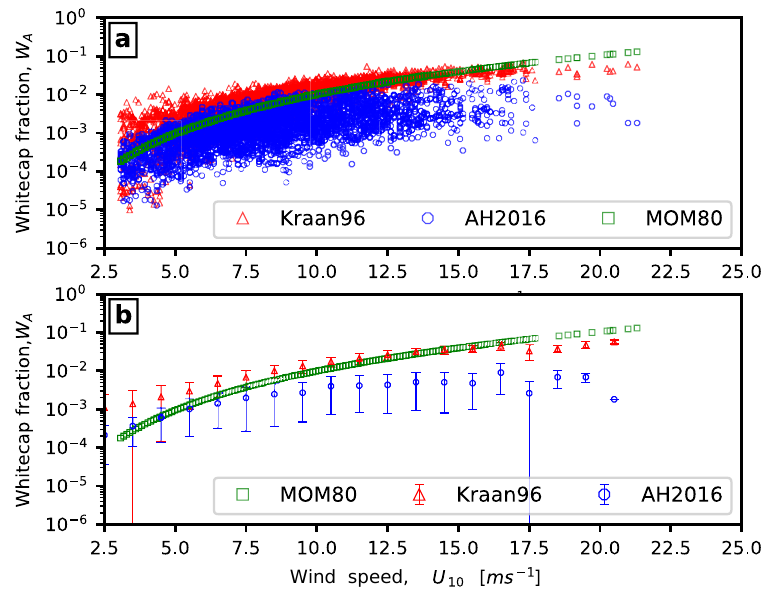
Figure 1. Wind speed dependence of the whitecap fraction (on log scale) obtained from (a) Kraan96 (Kraan et al., 1996), AH2016 (Anguelova and Hwang, 2016), and MOM80 (Monahan and Muircheartaigh, 1980). (b) As in (a) , but data are binned in wind speed bins of 1ms − 1 using data from buoy 46001.